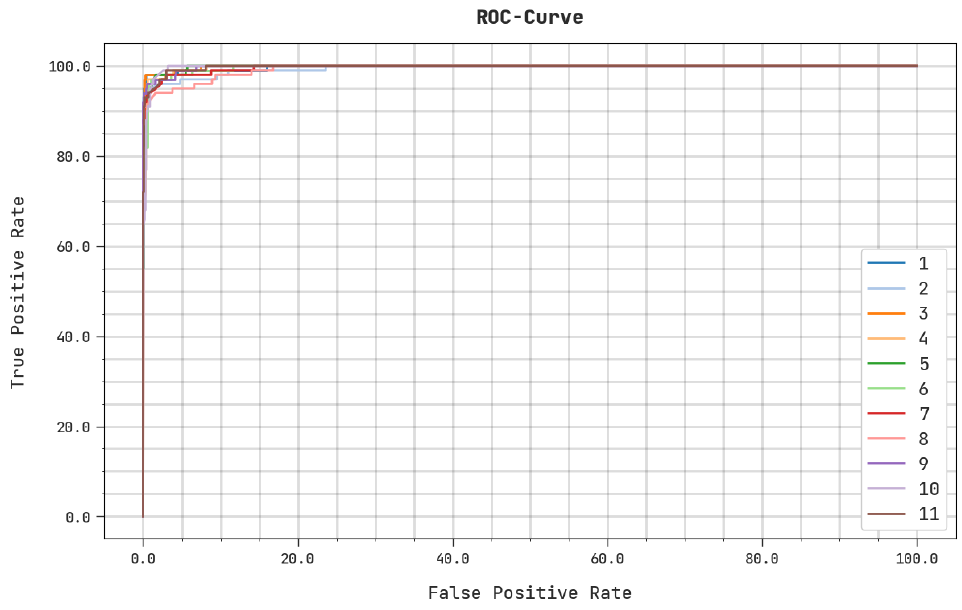
Figure 9. ROC analysis ASODCAE-SLR approach.